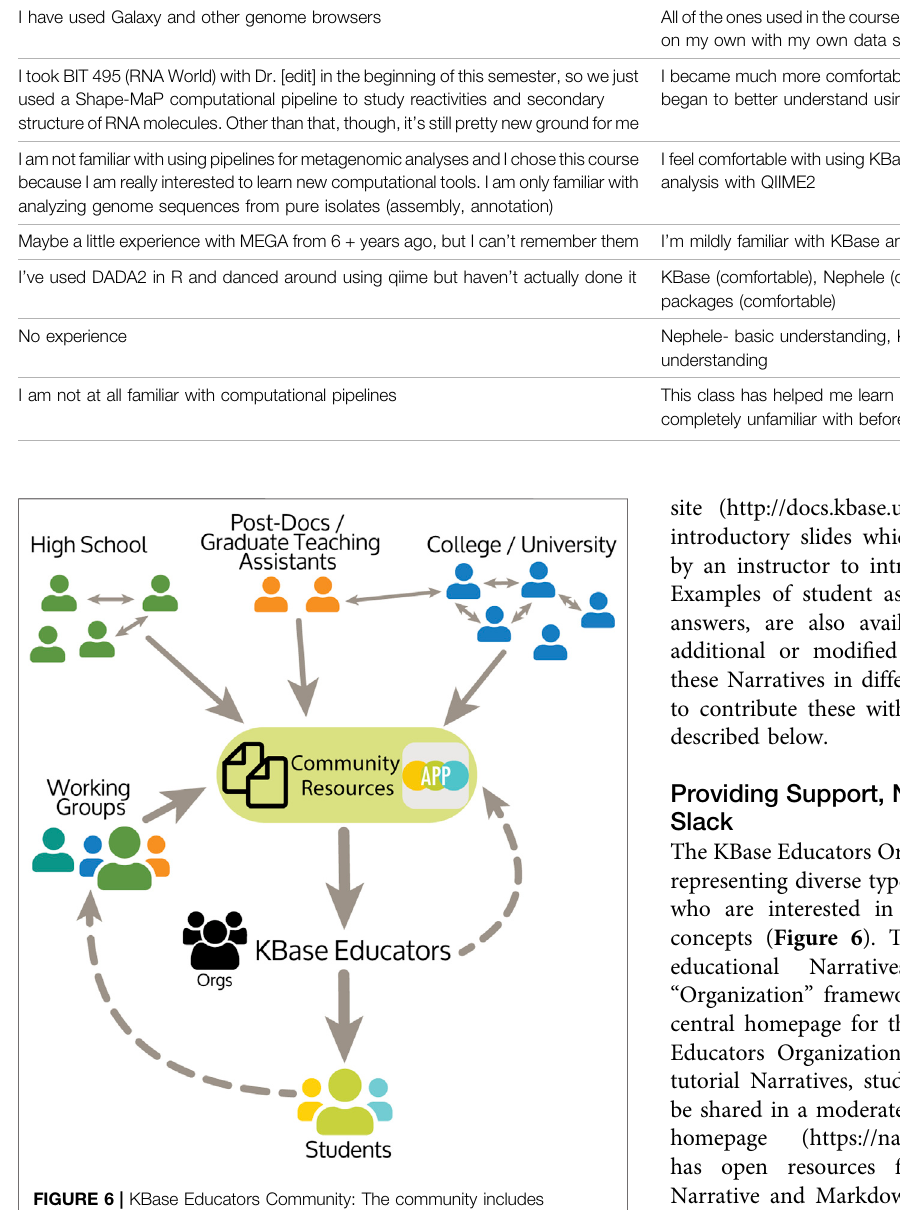
FIGURE 6 | KBase Educators Community: The community includes instructors that teach at High School and college levels. Resources are developed by the community, including teaching Narratives using bioinformatics tools wrapped as KBase Apps and supporting documentation. Working groups have developed work fl ows across common topics. From student and community feedback, resources including teaching Narratives, are improved and added to the KBase Educators